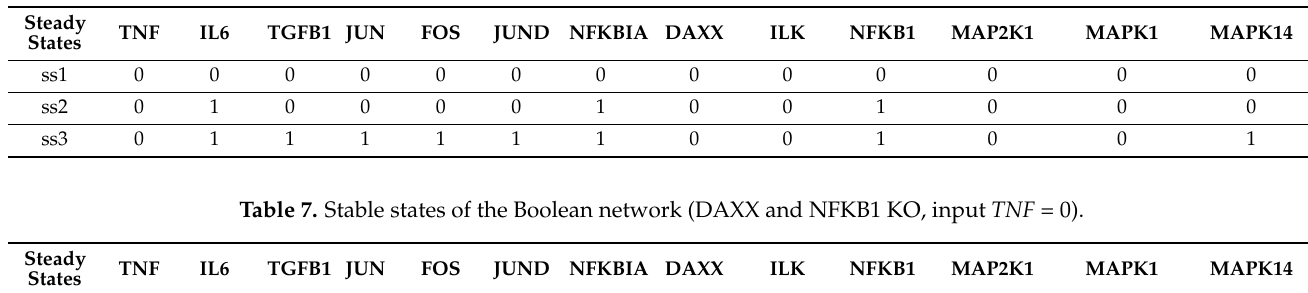
Table 6. Stable states of the Boolean network (DAXX, ILK and MAP2K1 KO, input TNF = 0).